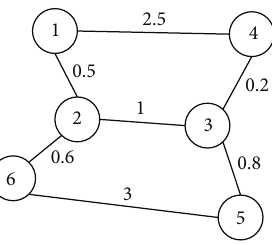
Figure 1: Communication topology of the multiagent systems.